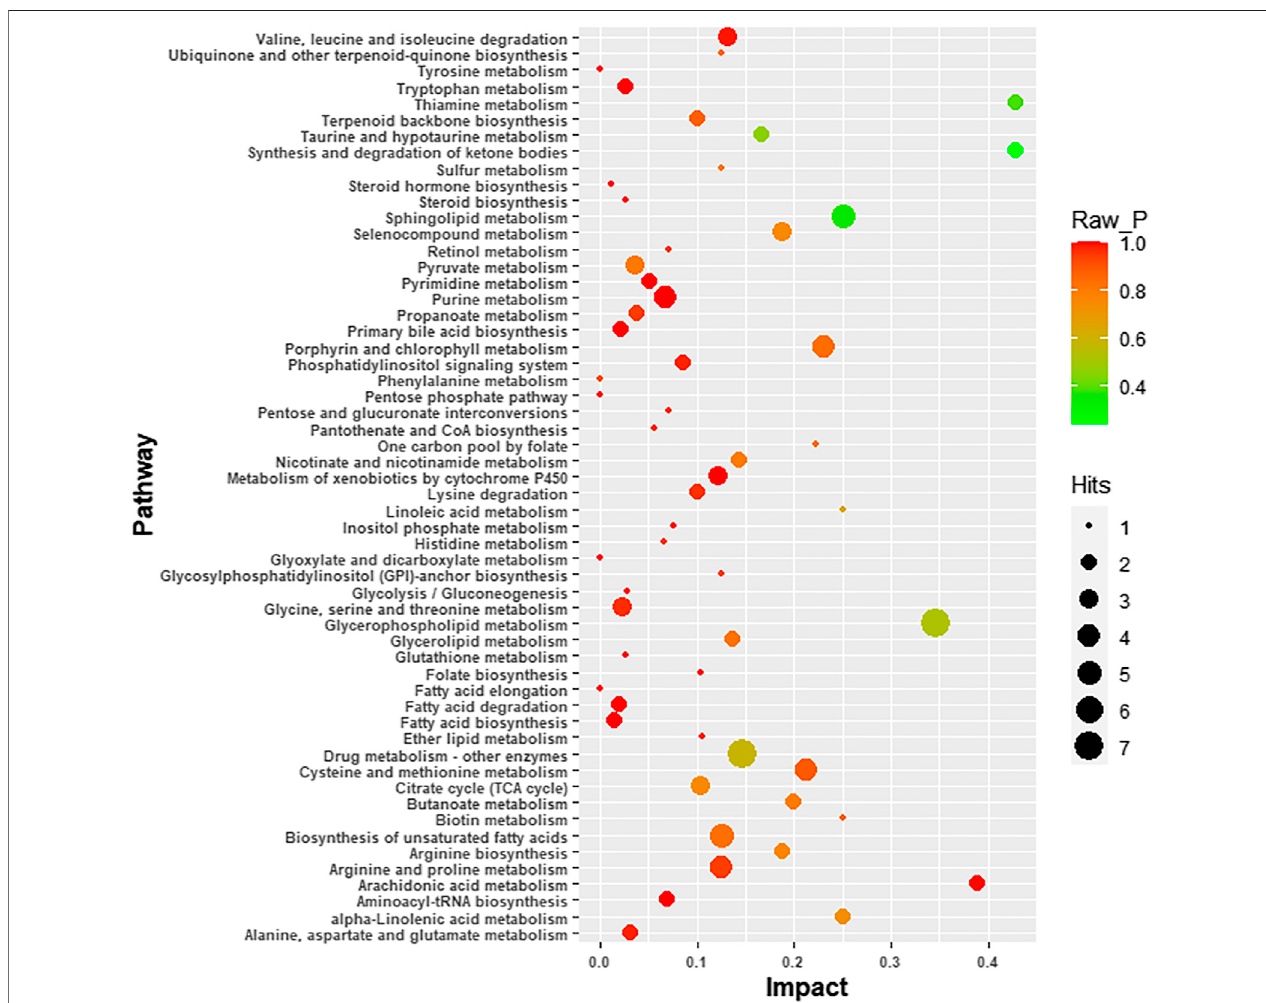
FIGURE 3 | Schematic diagram of the altered metabolic